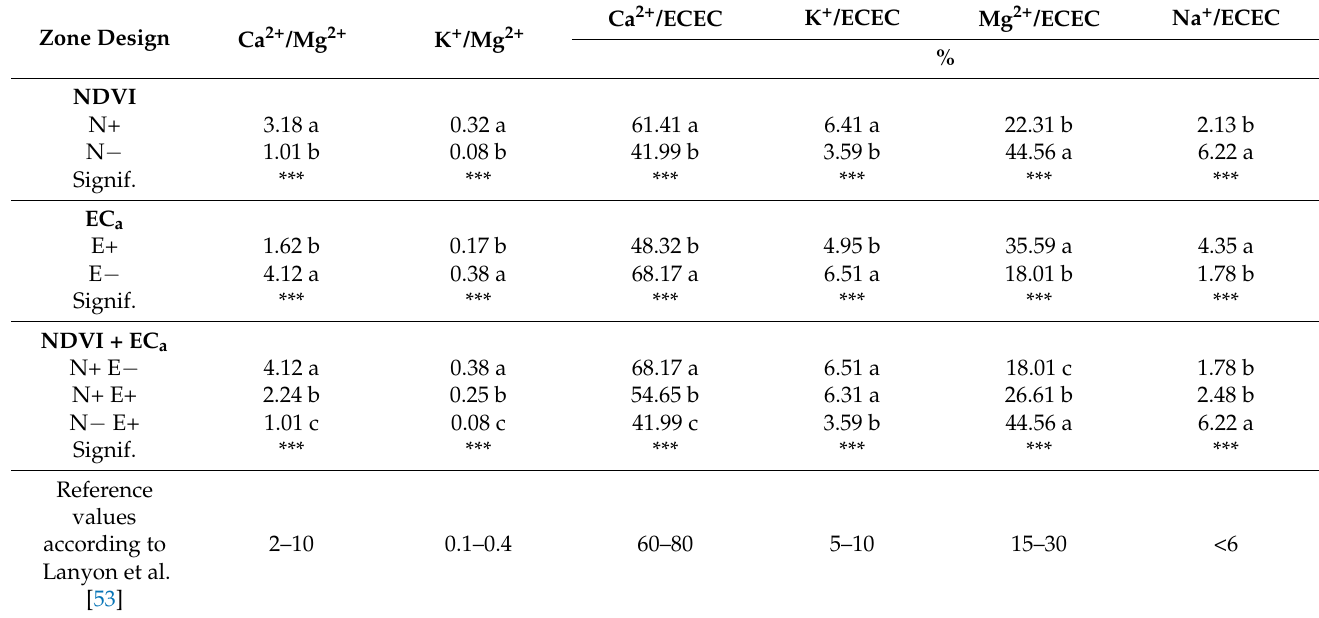
Table 4. Mean values of ratios between Ca 2+ and Mg 2+ and K + and Mg 2+ and percentages of the cations within the effective cation exchange capacity (ECEC) according to zone and indicator used. Also shown are the “suggested criteria for soil chemical status for sustainable vine health for wine grape production”